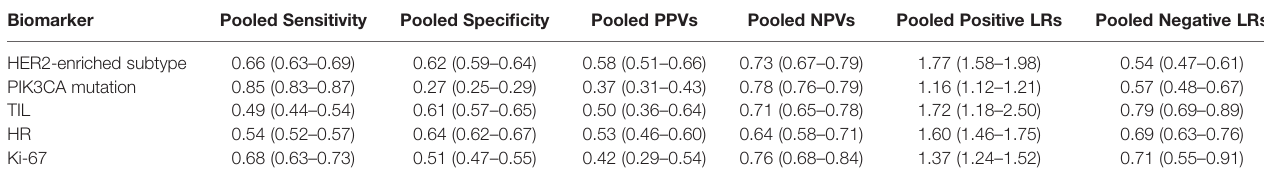
TABLE 1 | Summary of the pooled sensitivities, speci fi cities, positive and negative predictive values, and likelihood ratios of various biomarkers for predicting pathologically complete response. Biomarker Pooled Sensitivity Pooled Speci fi city Pooled PPVs Pooled NPVs Pooled Positive LRs Pooled Negative LRs HER2-enriched